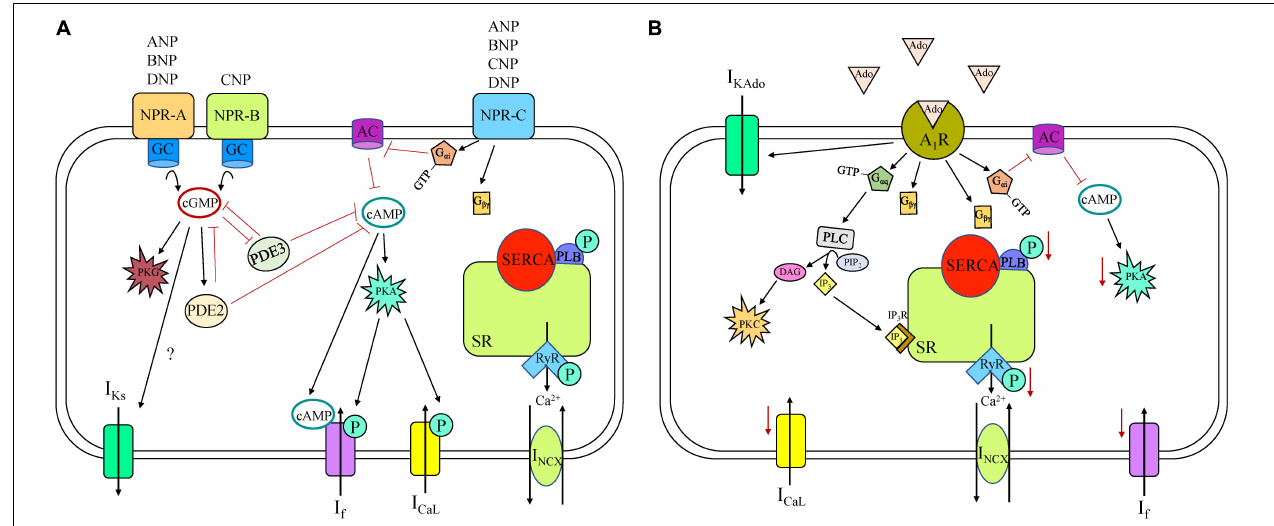
FIGURE 4 | Natriuretic peptide receptor (NPR) (A) and adenosine (B) receptor signaling cascade in a sinoatrial node myocyte. A 1 R, adenosine receptor 1; AC, adenylyl cyclase; ANP, atrial natriuretic peptide; BNP, brain natriuretic peptide; cAMP, cyclic adenosine monophosphate; cGMP, cyclic guanosine monophosphate; CNP, C-type natriuretic peptide; DAG, diacylglycerol; DNP, Dendroaspis natriuretic peptide; GC, guanylyl cyclase; I CaL , long-lasting (L-type) Ca 2 + current; I f , “funny” current; I KAdo , adenosine-induced inwardly rectifying K + current; I Ks , slow delayed rectifier K + current; I NCX , Na + -Ca 2 + exchanger current; IP 3 , inositol triphosphate; IP 3 R, inositol triphosphate receptor; P, phosphorylation; PDE, phosphodiesterase; PIP 2 , Phosphatidylinositol 4,5-bisphosphate; PKA, phosphokinase A; PKC, phosphokinase C; PKG, phosphokinase G; PLB, phospholamban; PLC, phospholipase C; RyR, ryanodine receptor, SERCA, sarco/endoplasmic reticulum Ca 2 + -ATPase; SR, sarcoplasmic